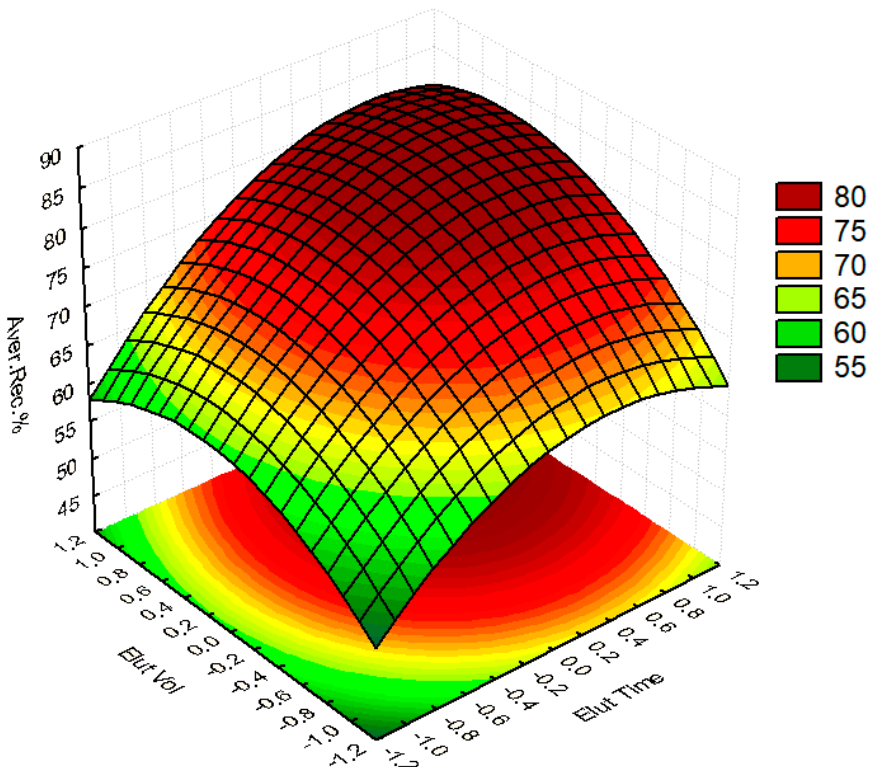
Separations 2020 , 7 , x FOR PEER REVIEW Figure 3. 3D Response Surface representation of elution time and solvent volume (coded values).